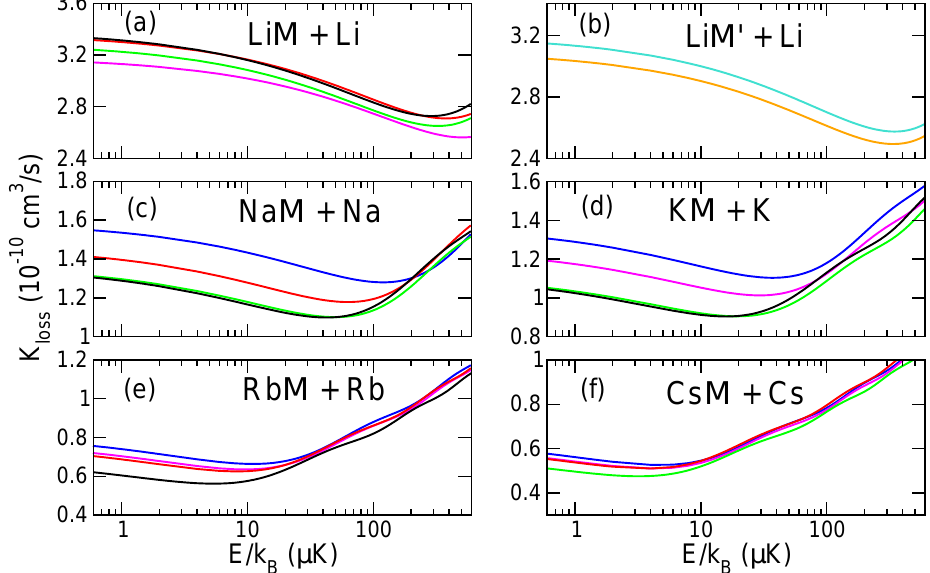
Figure 3. Inelastic reaction or quenching rate coefficients for alkali-metal, Strontium and Ytterbium atom-molecule collisions as functions of collision energy based on the universal model. The six panels show rate coefficients for the AM(M’) + A collision, where A is either Li, Na, K, Rb, or Cs. In panels ( a , c – f ) blue, dark green, red, green, and black curves correspond to rate coefficients for atom M = Li, Na, K, Rb, and Cs, respectively. In panel ( b ) cyan and orange curves correspond to M’ = Sr and Yb, respectively. The molecules are prepared in their X 1 Σ + ground state for alkali-metal dimers and in their X 2 Σ + ground state for alkali-metal Sr or alkali-metal Yb dimers. Scattering is only reactive when the mass of atom A is less than that of M(M’). When the mass of A is larger than that of M(M’), quenching rate coefficients are